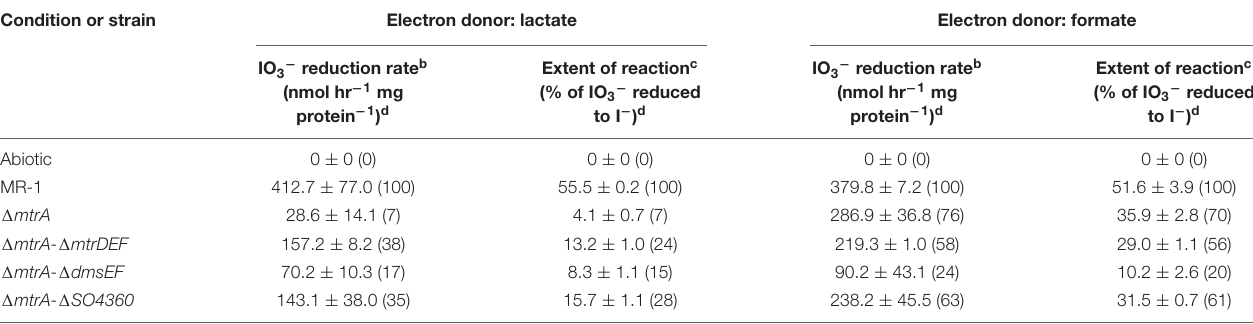
TABLE 1 | IO 3 − reduction activities of wild-type and EEC paralog mutant strains of Shewanella oneidensis with lactate and formate as electron donors. a